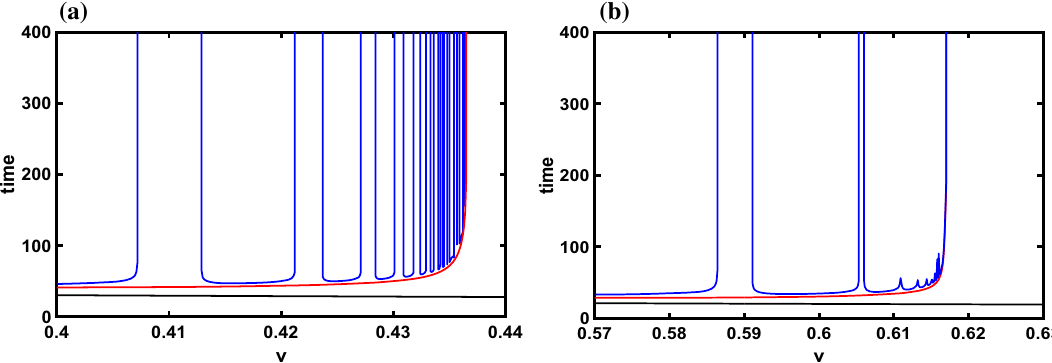
Fig. 14 Time to the first (black), second (red) and third (blue) antikink-kink collision as a function of initial velocity v for a n = 3 and b n = 5